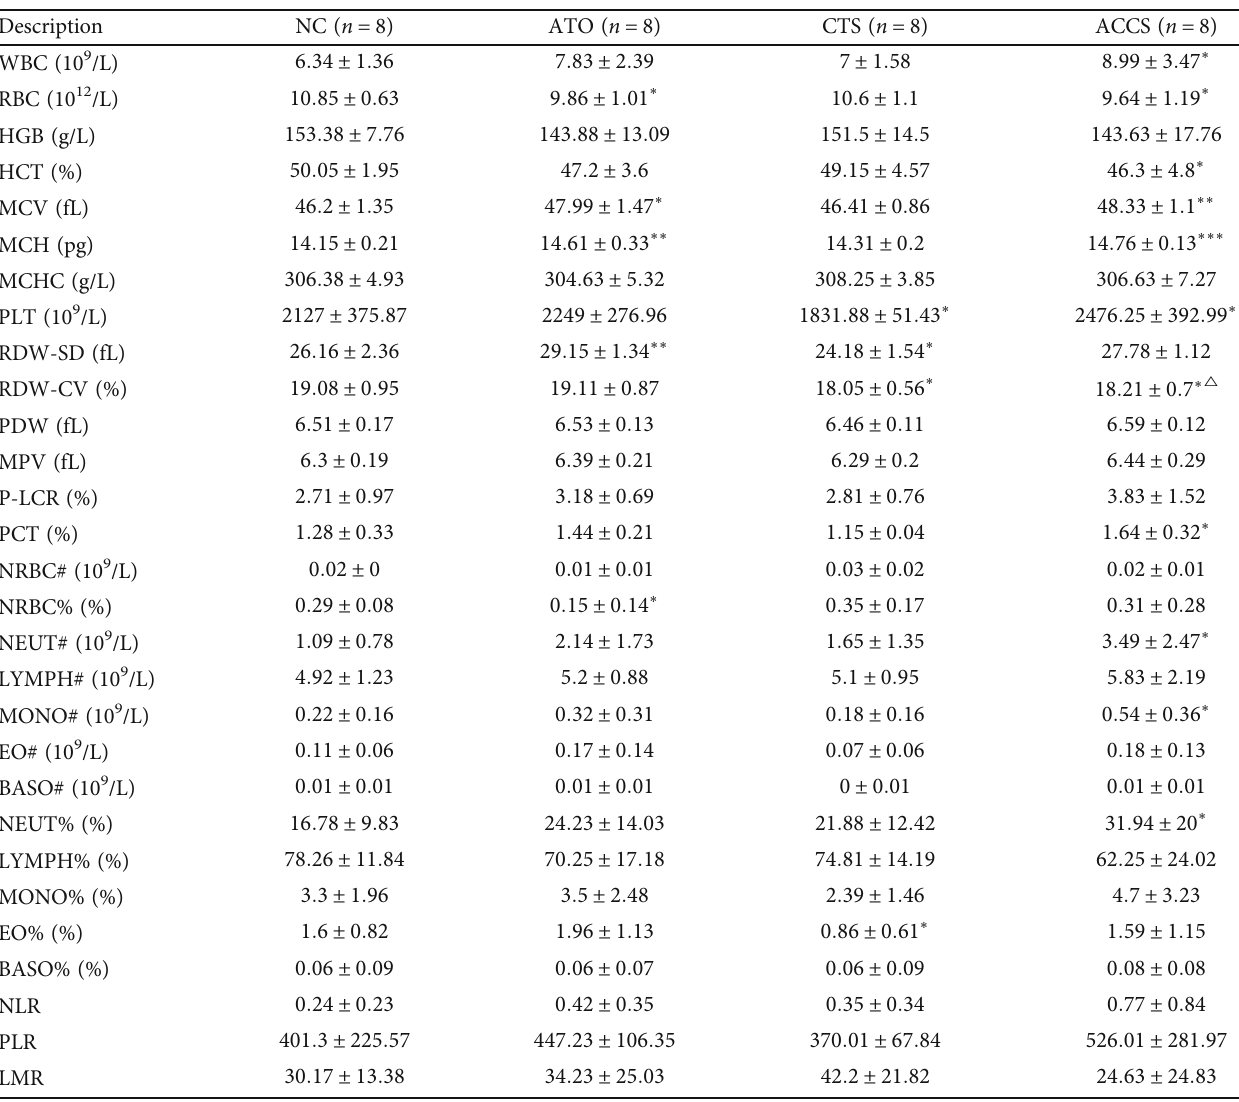
Figure 2: The e ff ects of ACCS in H22 mice xenograft tumors. (a) Representative image of tumor. (b) Tumor weight at 21 days. (c) Tumor growth inhibition curve after treatment. (d, e) Immunohistochemistry of PCNA in tumor tissue. (f, g) Immunohistochemistry of Ki67 in tumor tissue. Table 2: Blood routine examination of